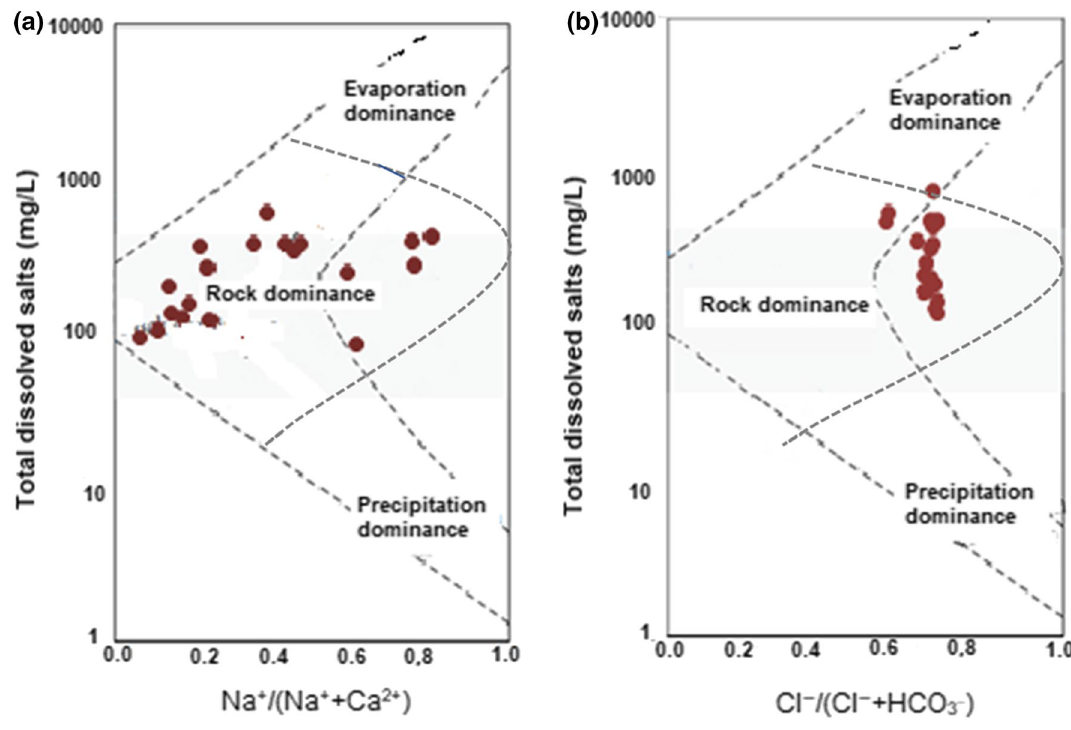
Fig. 7 Gibbs diagrams indicating the groundwater natural evolution mechanisms; a TDS vs. Na + /(Na + + Ca 2+ ) and b TDS vs. Cl − /(Cl − + HCO 3–